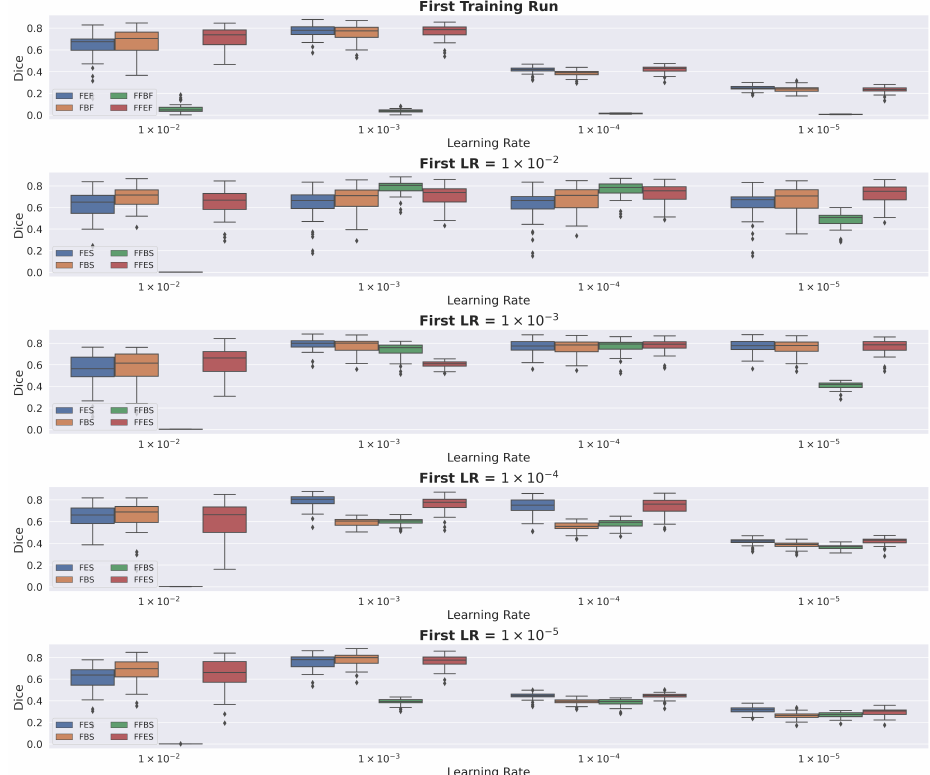
Figure A1. Box plots displaying the spread of Dice scores among the volumes in the MRI test set. The top row displays the spread of Dice scores after each type of model was trained once, with the initial learning rate set to the appropriate value on the x-axis. The remaining four rows display the spread of Dice scores after each model in the first row was trained again, with the initial learning rate set to the appropriate value on the x-axis. We used the following structure for acronyms to distinguish between the different types of models: ABC . If A is F, the pretrained weights were fine-tuned immediately, and if A is FF, the pretrained weights were first frozen and then fine-tuned. If B is E, only the pretrained encoder weights were transferred, and if B is B, both the pretrained encoder and decoder weights were transferred. If C is F, the model was trained only once (the first training run), and if C is S, the model was trained a second time (the second training